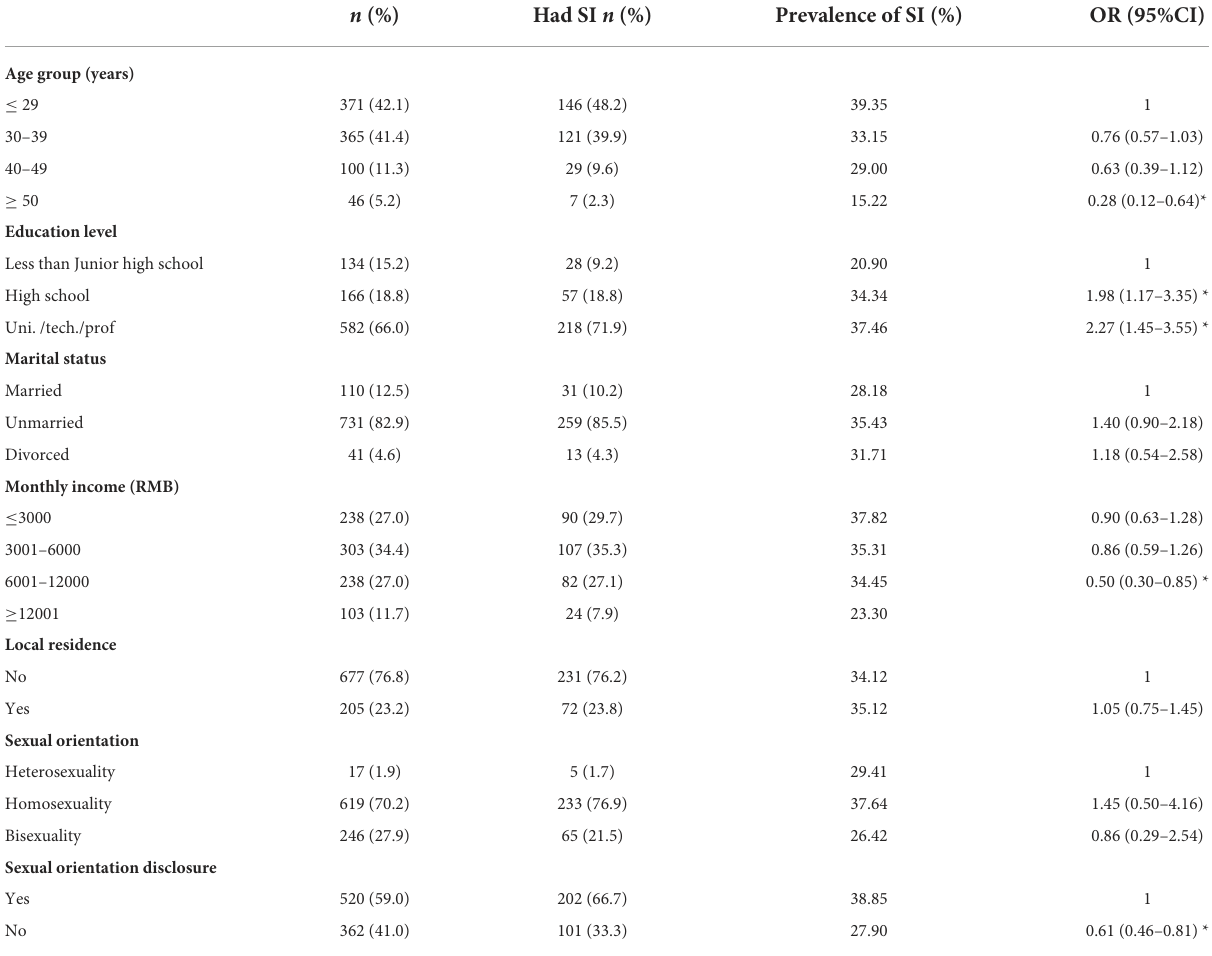
TABLE 1 Background factors and their associations with suicidal ideation ( n =